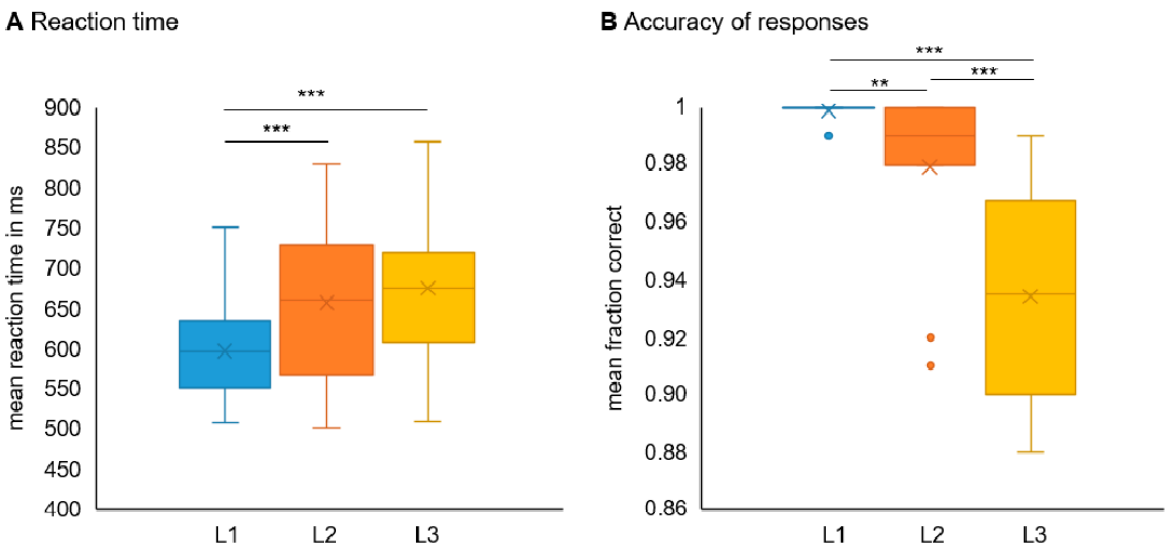
Figure 6. The behavioral analysis confirmed the experimental conditions as reflected by increasing task demand with slower responses and reduced accuracy across the three conditions (corresponding to difficulty levels L1, L2, L3). ( A ) Mean reaction times across days for each condition. A significant main effect of condition emerged. Post hoc tests indicate a significant difference between L1 and L2 and L1 and L3. *** p = 0.001. ( B ) Mean fraction of correct responses across days for each condition. A significant main effect of condition emerged. Post hoc tests indicate a significant difference between all conditions. *** p = 0.001, ** p = 0.005.